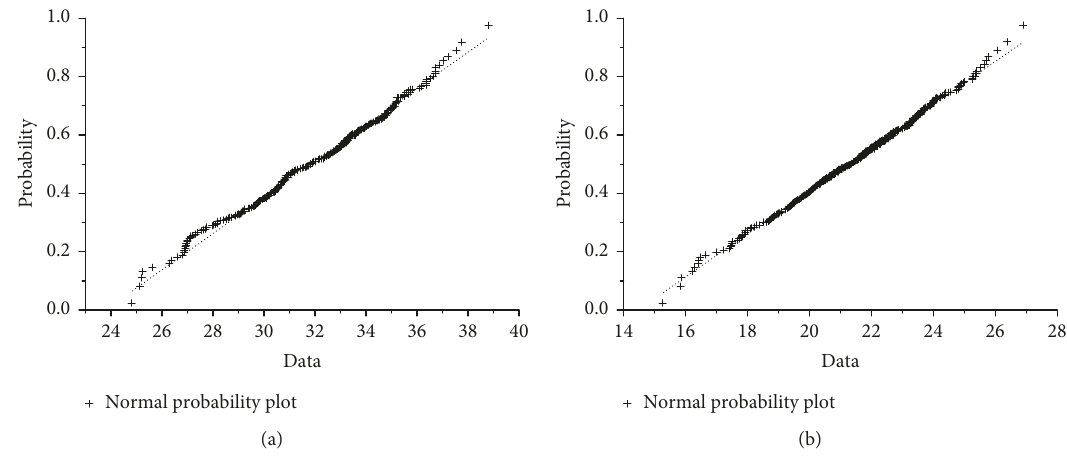
Figure 8: The distribution probability diagram of the daily extreme value of axial uniform temperature in October. (a) The maximum. (b) The minimum.